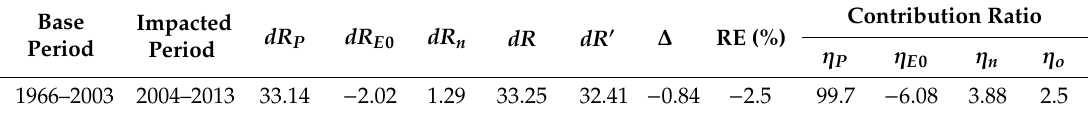
Table 4. Contributions of P , E 0 , n and coupled other factors to runo ff depth